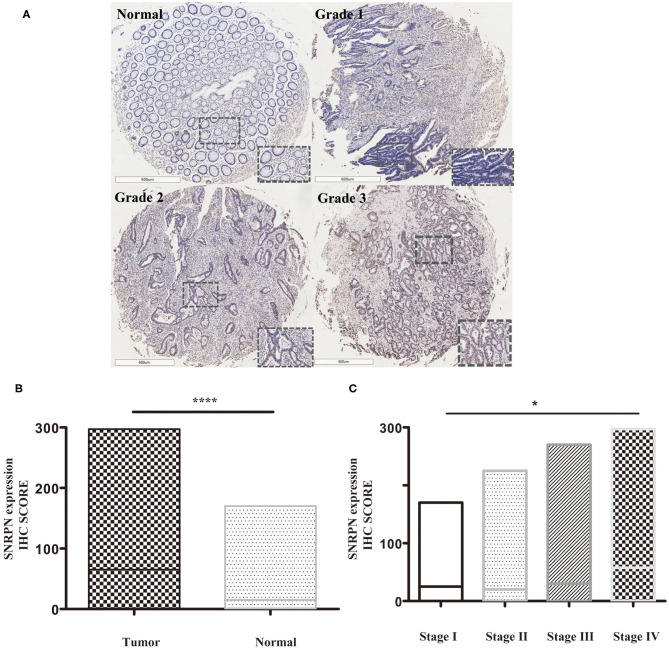
SNRPN is highly expressed in colorectal cancer tumor tissues. Immunohistochemistry (IHC) staining of SNRPN in colorectal cancer tissues. (A) Representative images of IHC staining intensity: normal—no staining, grade 1—weak staining, grade 2—moderate staining, and grade 3—strong staining. (B) IHC staining score of SNRPN was significantly higher in tumor tissues than in normal tissues. (C) IHC staining score of SNRPN in four stages. *P < 0.05; ****P < 0.001. P value: Wilcoxon signed rank test (matched pairs).